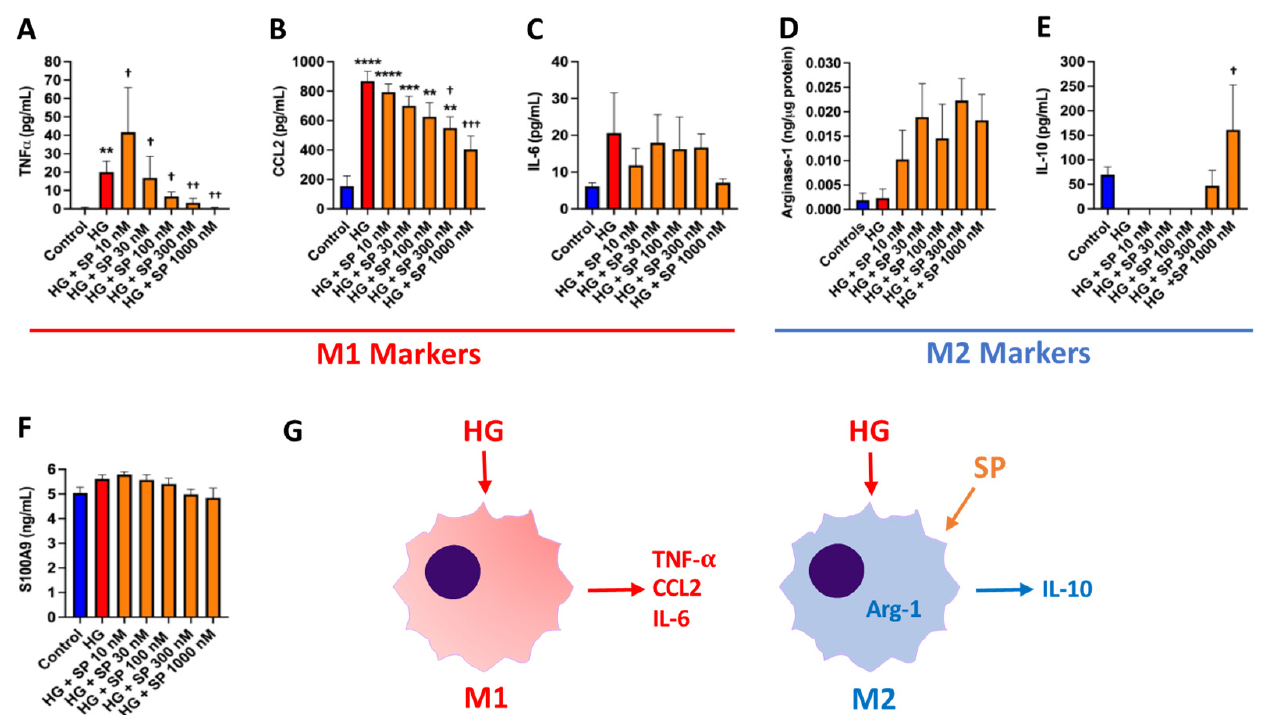
Figure 4. SP promotes an M2 macrophage phenotype in vitro. Macrophage M1 phenotype markers ( A ) TNF- α ; ( B ) CCL2; and ( C ) IL-6 in cultured BMMF culture media in response to normal glucose (control, 5 mM), high glucose (HG, 25 mM), and HG with increasing concentrations of SP (10 to 1000 nM). M2 macrophage phenotype markers ( D ) arginase-1; and ( E ) IL-10 in cultured BMMF lysates and media, respectively, in response to normal glucose (control, 5 mM), high glucose (HG, 25 mM), and HG with increasing concentrations of SP (10 to 1000 nM); ( F ) S100A9 levels in cultured BMMF culture media in response to normal glucose, HG, and HG with increasing concentrations of SP; and ( G ) Schematic showing the M1 and M2 macrophage phenotype and markers in response to HG, as well as the effect of SP on macrophage phenotype. Data are expressed as mean ± SEM and were analyzed by one-way ANOVA with Tukey post hoc test; ** p < 0.01 vs. control, *** p < 0.001 vs. control, **** p < 0.0001 vs. control, † p < 0.05 vs. HG, †† p < 0.01 vs. HG, ††† p < 0.001 vs. HG. n = 4–6 for control and n = 5–6 for all other groups.